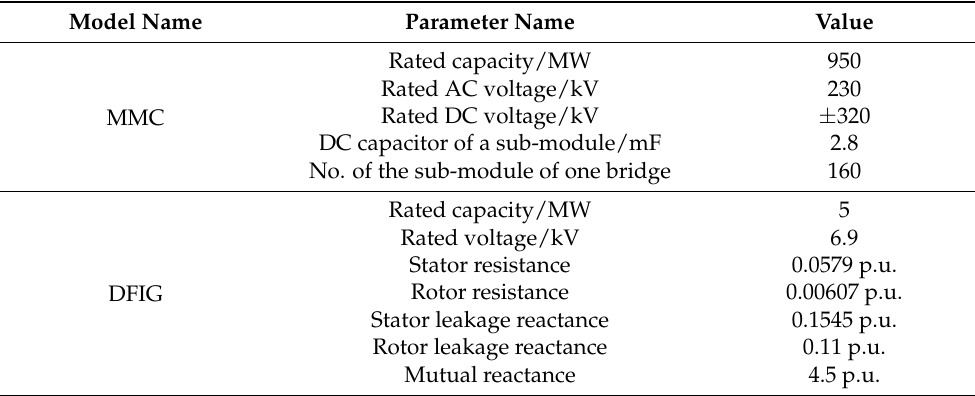
Table 1. Parameters of the MMC-HVDC system with an offshore wind